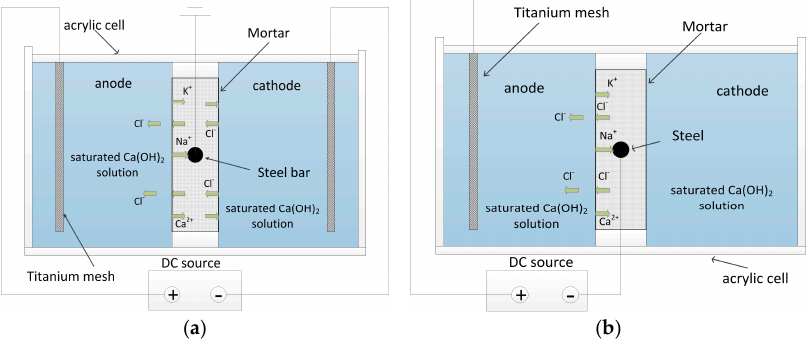
Figure 2. Detailed experimental configurations for the modified electrode configuration